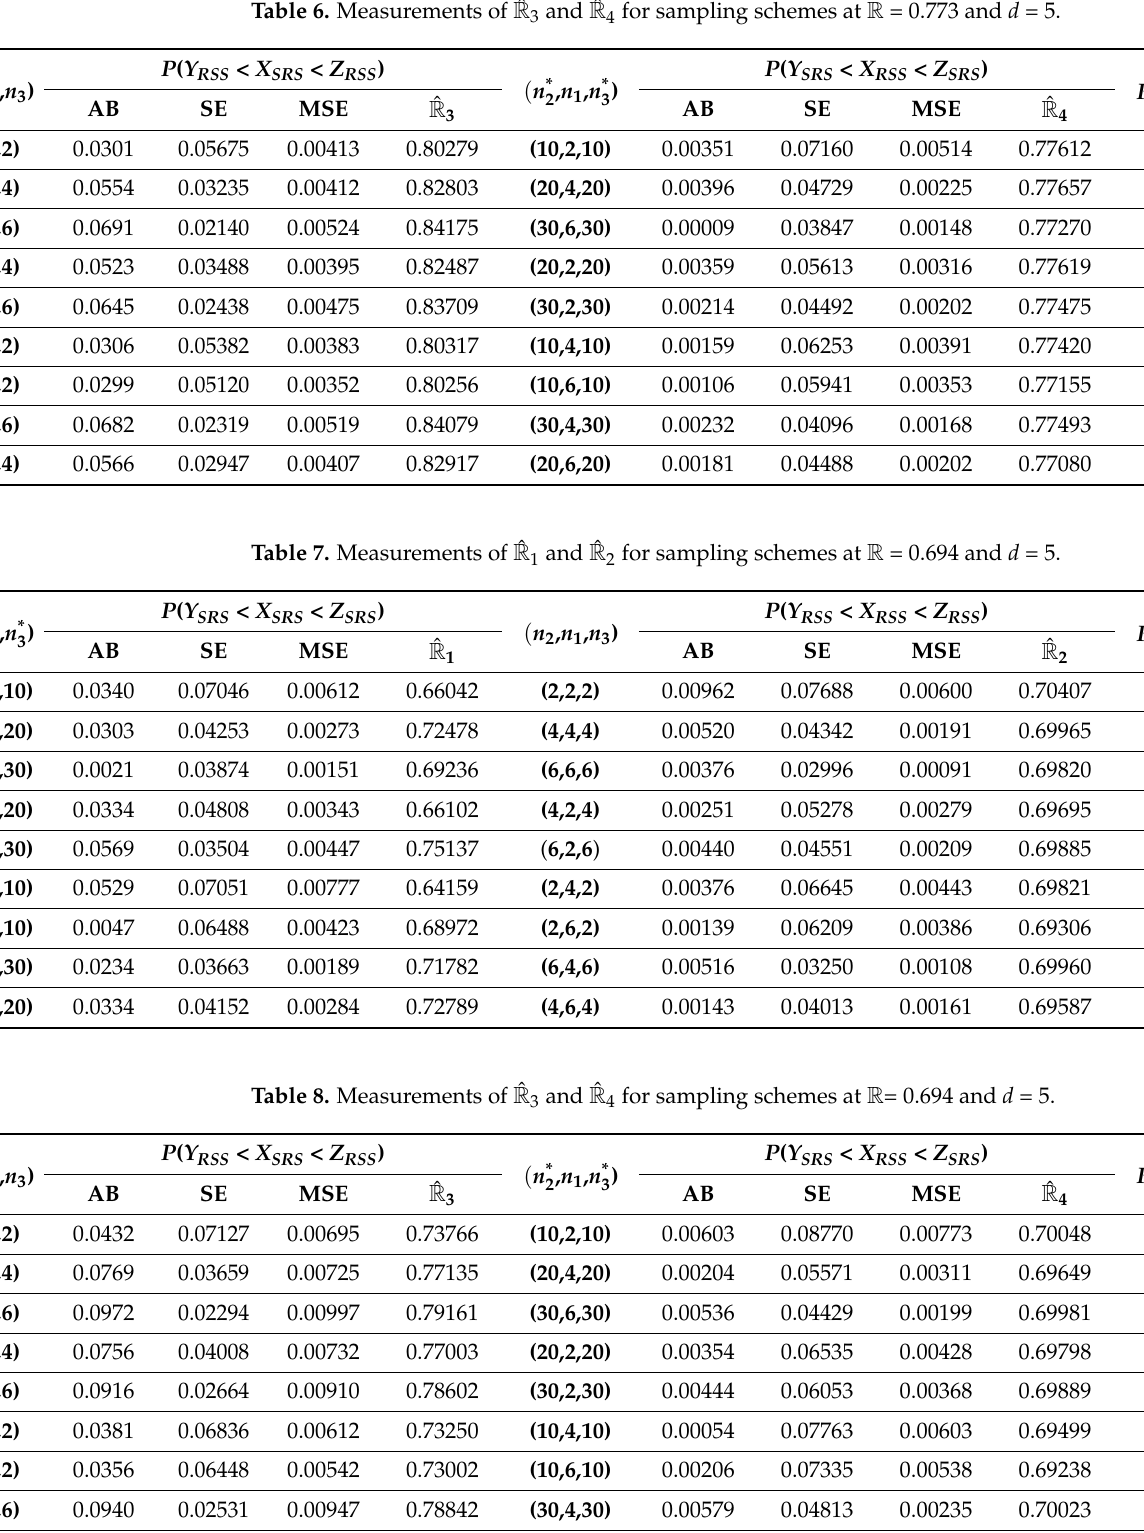
Table 6. Measurements of ˆ R 3 and ˆ R 4 for sampling schemes at R = 0.773 and d = 5.